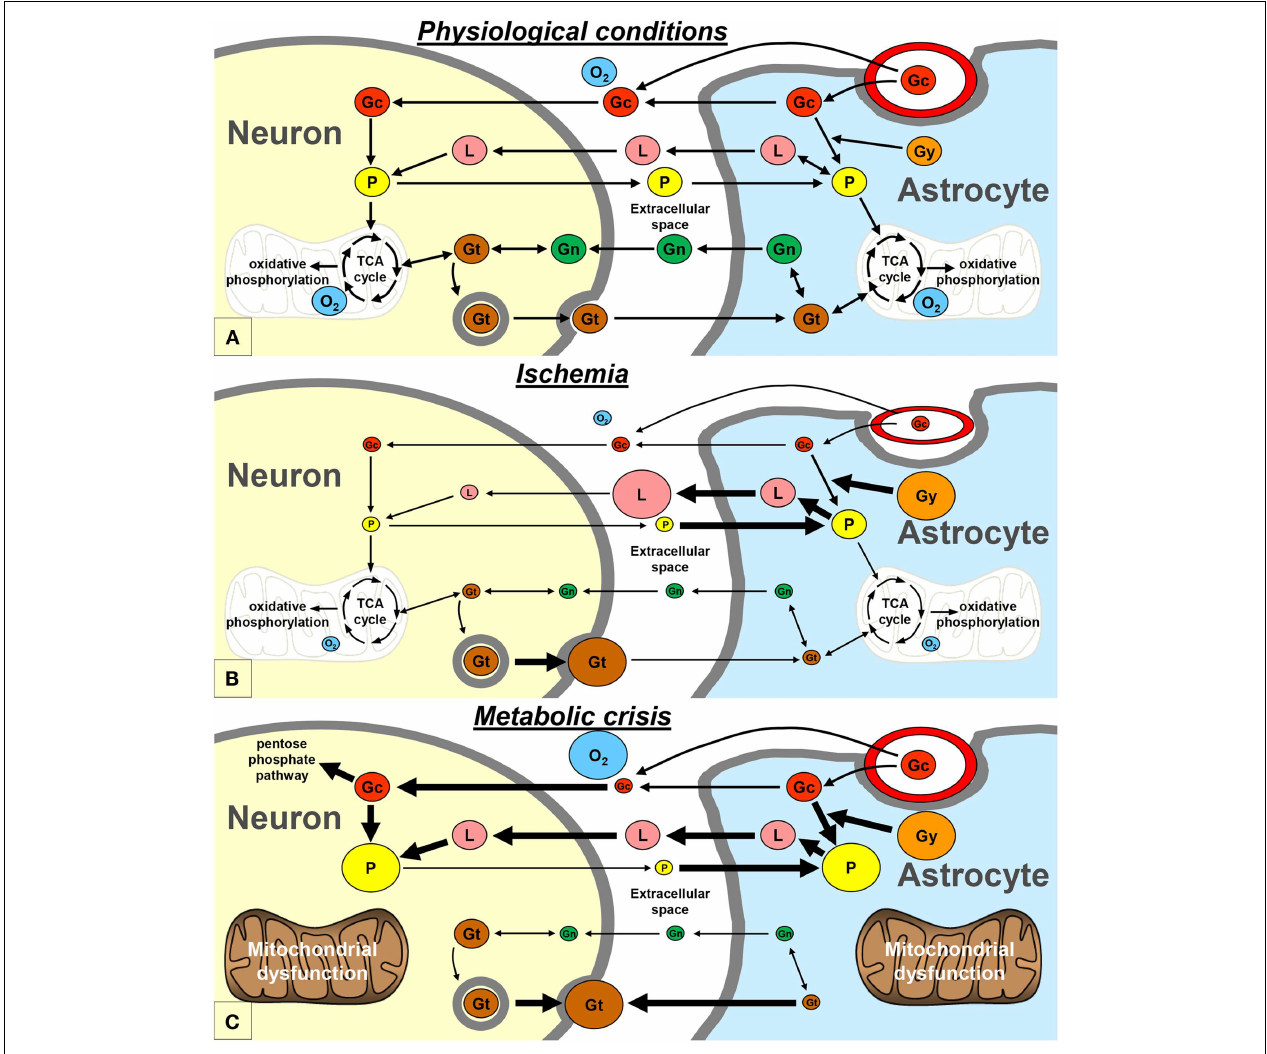
FIGURE 2 | Schematic representation of the proposed exchange of energetic metabolites between neurons and astrocytes, in physiological conditions (A), during ischemia (B), and during metabolic crisis (C) . Gc, glucose; Gg, glycogen; Gn, glutamine; Gt, glutamate; L, lactate; O 2 , oxygen; P, pyruvate;TCA, tricarboxylic